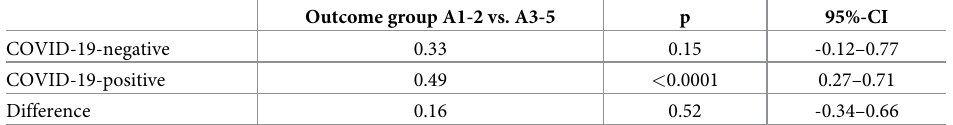
Table 2. Associations between day 0 plasma ACE2 and maximal acuity group during the 28-day period (Acuity max) in COVID-19-positive and negative patients in two-way analysis of variance